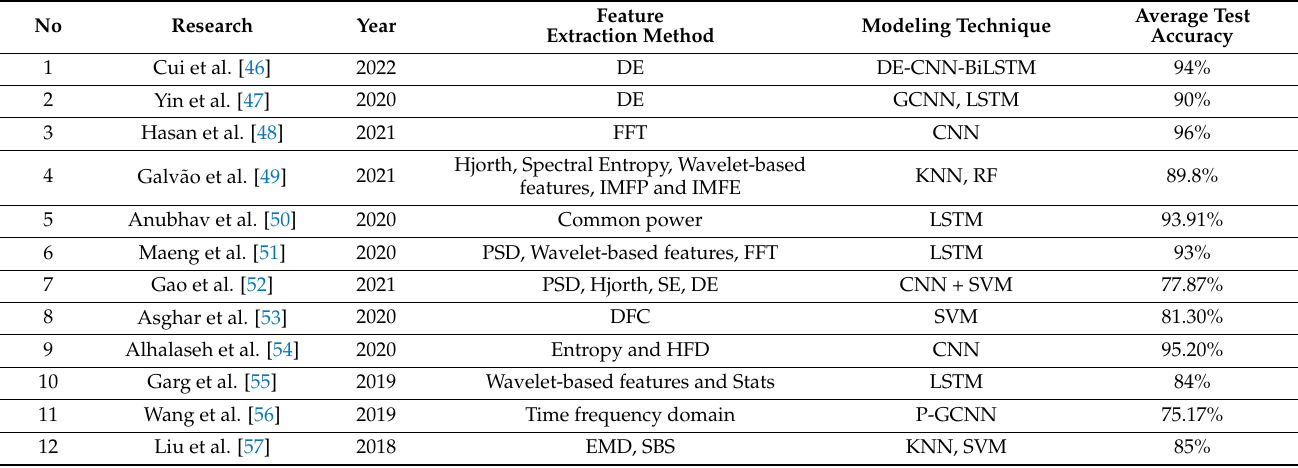
Table 1. Notable literature for the DEAP on binary classification of valence and arousal